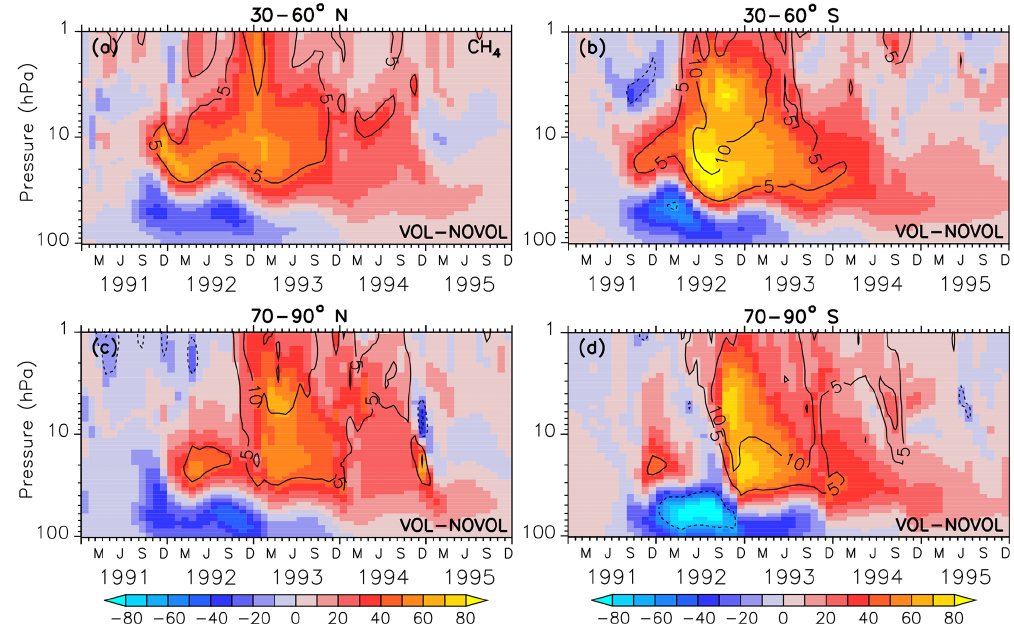
Figure 16. Zonally averaged differences in methane (ppbv) of the combined effect (VOL − NOVOL). The black contours show the relative change (%) in methane in VOL comparison to NOVOL. Shown are extratropical averages ( a, b : 30–60 ◦ N and 30–60 ◦ S; c, d : 70–90 ◦ N and 70–90 ◦ S). Contour intervals are